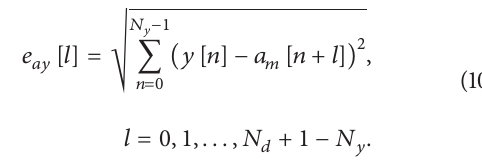
Figure 11: The MSE sequence.